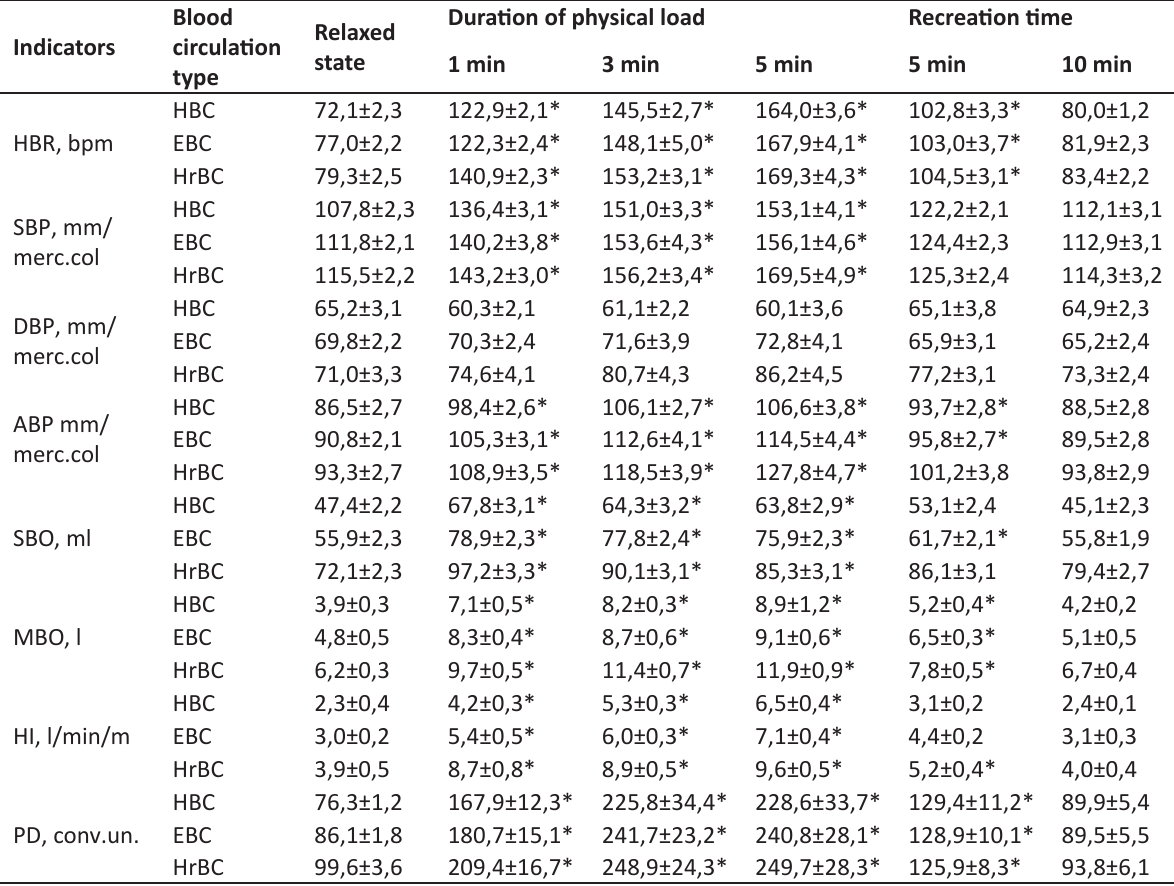
Table 2. Cardio-hemo-dynamic indicators of 2 nd group’s volleyball players with different blood circulation type before physical load and in recreation period (M±m, n=11)